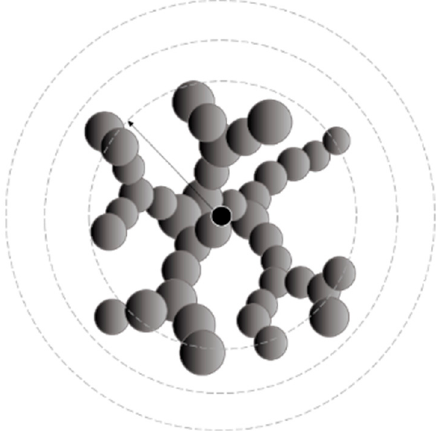
Figure 21. Scheme of porosity designation.